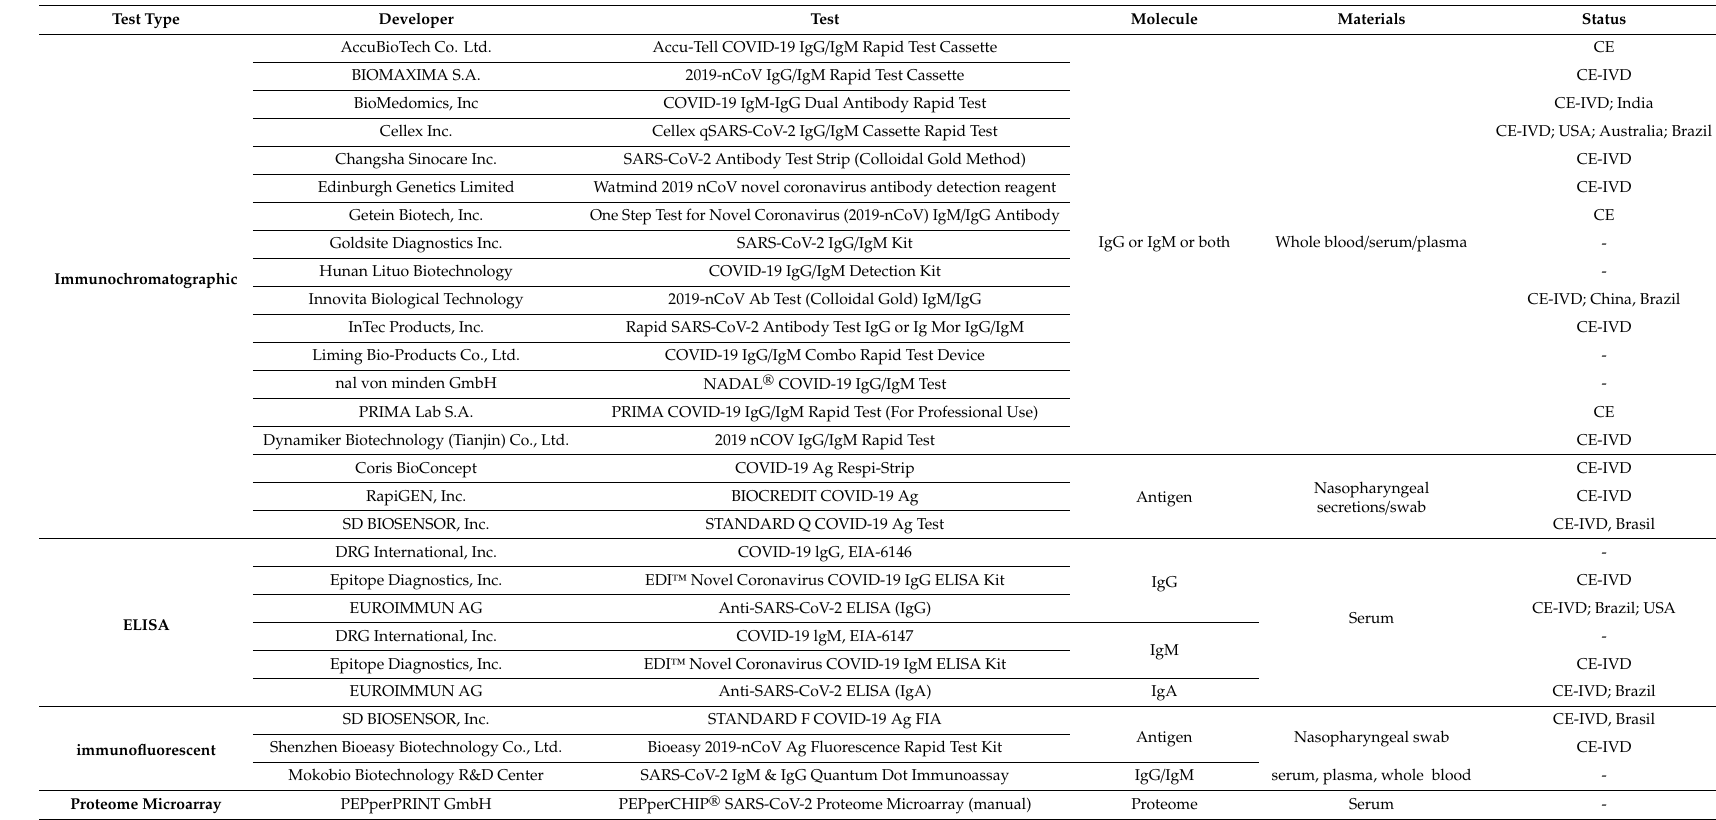
Table 8. The descriptive characteristics of available serological immunodiagnostic COVID-19 tests and based on antibody-antigen and specimen (updated 13 June 2020, online